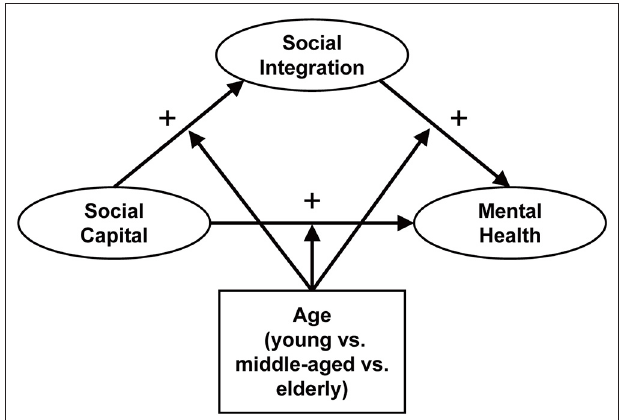
FIGURE 1 | Conceptual